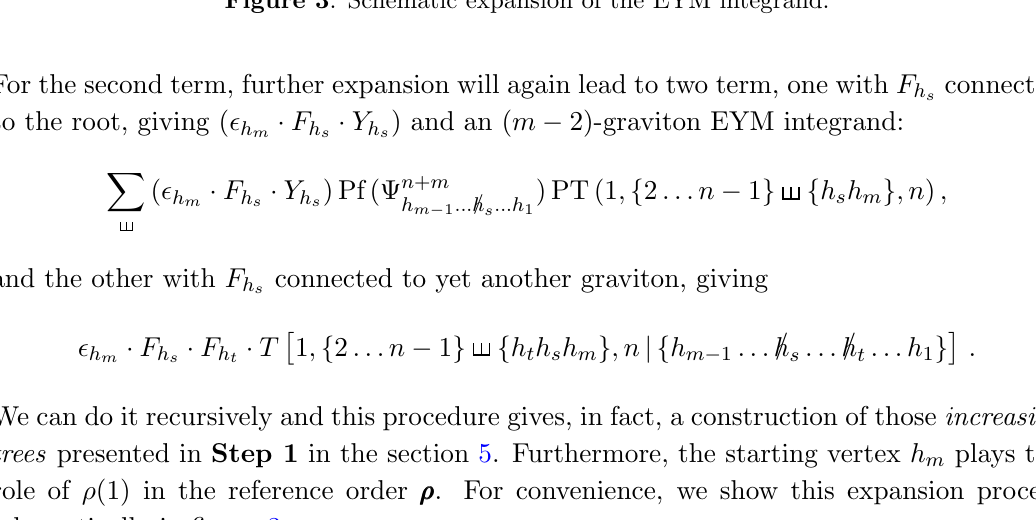
Figure 3 . Schematic expansion of the EYM